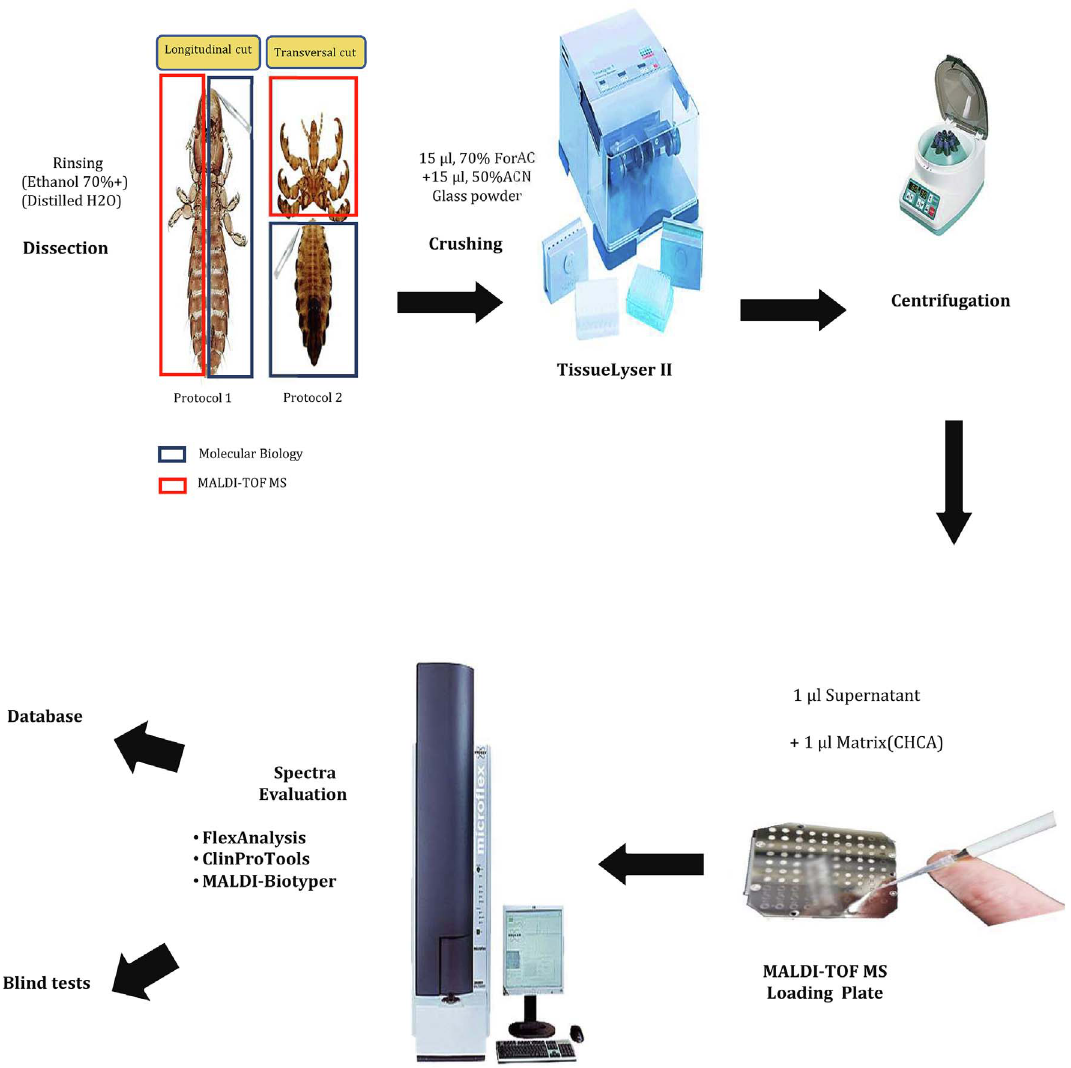
Figure 2. An explanatory fl owchart of the MALDI-TOF MS protocol. ACN: Acetonitrile, ForAC: Formic acid, CHCA: a -cyano-4- hydroxycinnamic